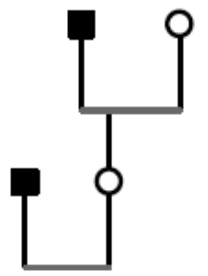
Figura 2 . Padrão de repetição de comportamento VAA por meio de casamento: mulher, com pai de comportamento VAA, que estabelece casamento com marido de comportamento semelhante ( N =24). Nota . Quadrados representam homens; círculos, mulheres; os símbolos preenchidos são indivíduos que apresentam associação